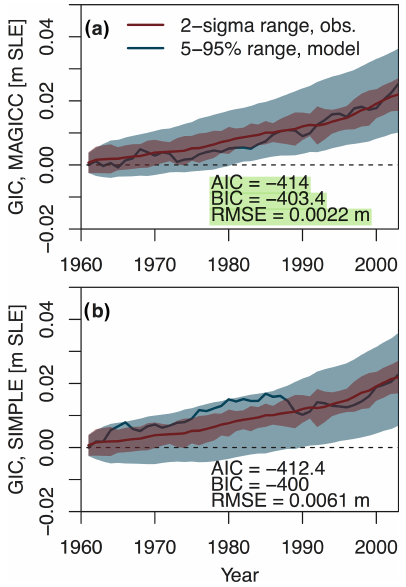
Figure 3. Comparison of (a) GIC-MAGICC vs. (b) GIC-SIMPLE model performance in hindcasting the glaciers and ice caps (GIC) contribution to sea-level rise. GIC sea-level rise is presented rela- tive to 1960 GIC sea-level contribution. Lower values of the AIC, BIC, and RMSE indicate a better model fit to the data (Dyurgerov and Meier, 2005). These error metrics are all calculated using the maximum likelihood ensemble member, which is represented by the solid blue line. Green highlighting indicates the model structure suggested by each comparison